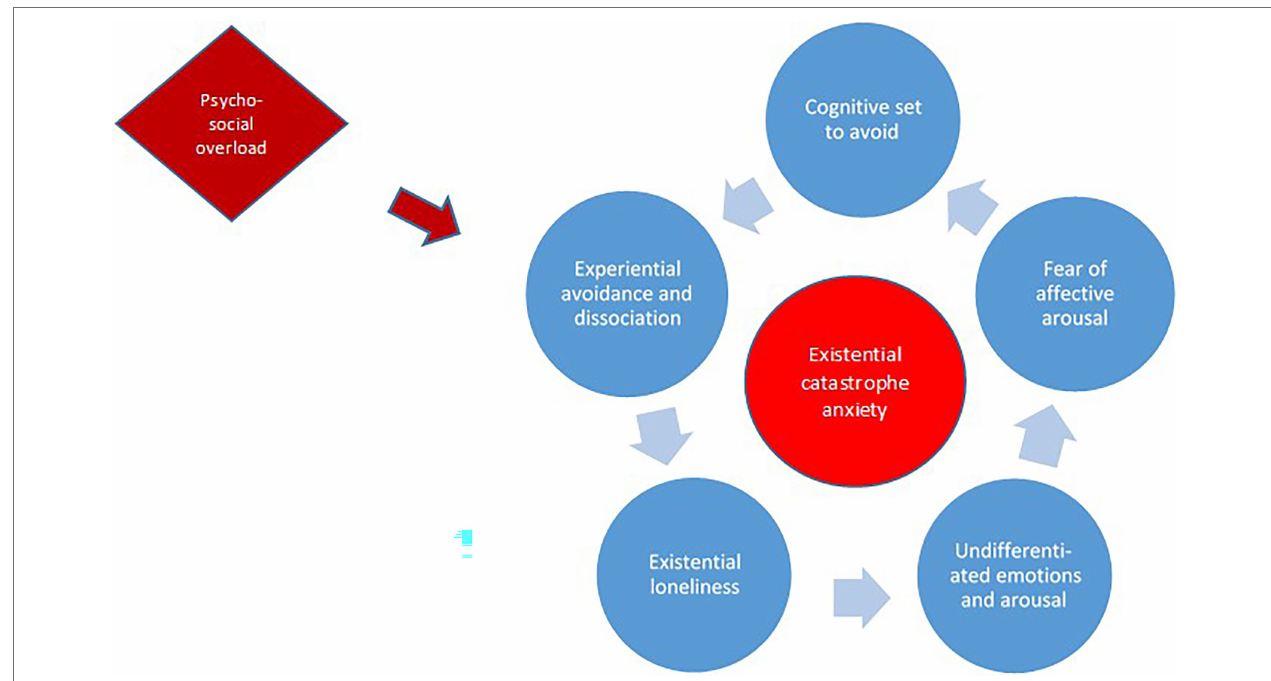
FIGURE 1 | Hypothesized interacting processes in developing and maintaining existential catastrophe anxiety. See main text for